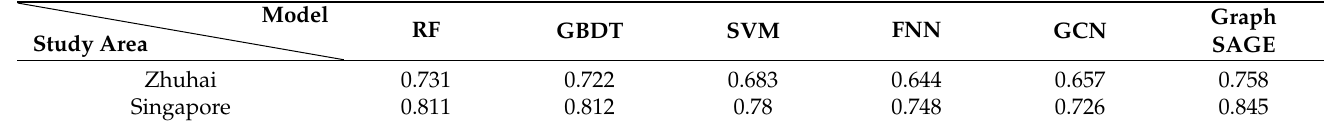
Table 10. Overall accuracy of UFZ classification results using different models.